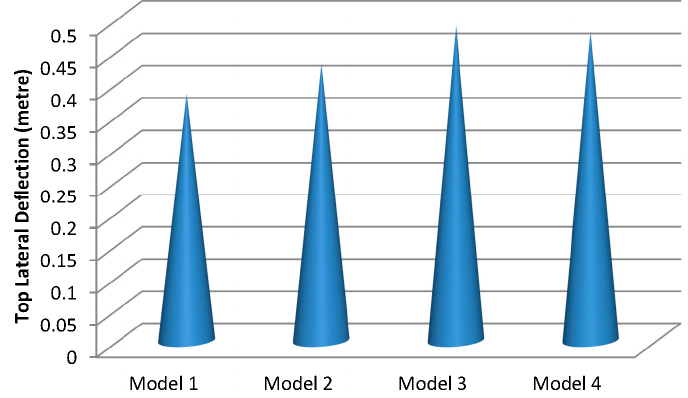
Figure 20. Top lateral deflection of buildings 120 stories high with bracing angle of 63.43° for all